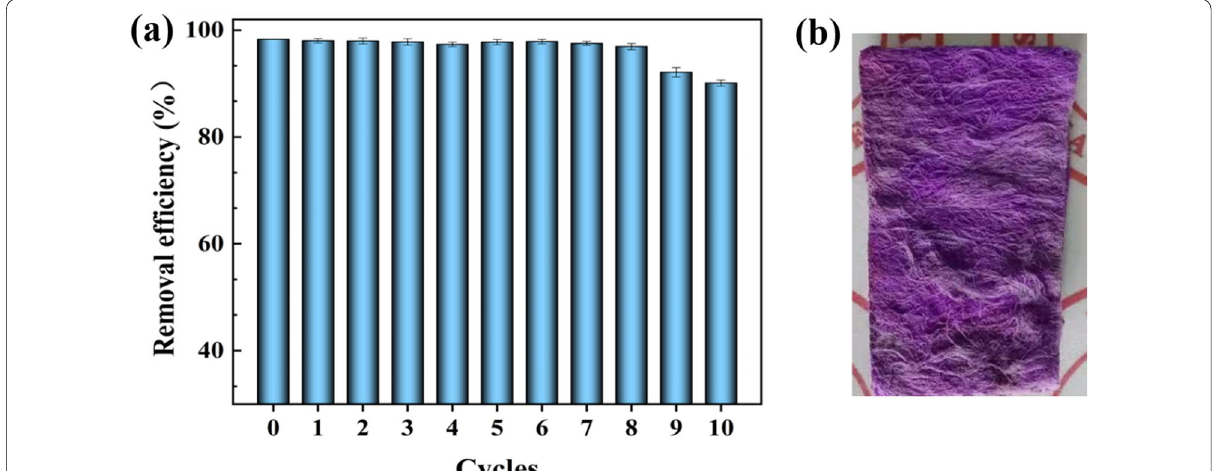
Fig. 7 Removal efficiency of the regenerated ZIF-67/cotton fibers toward MG ( a ) and the optical image of the ZIF-67/cotton fibers ( b ) after 10 successive adsorption–desorption cycles (adsorption conditions: mass of adsorbent, 100 mg; initial dye concentration, 20 mg/L; volume of dye solution, 50 mL)